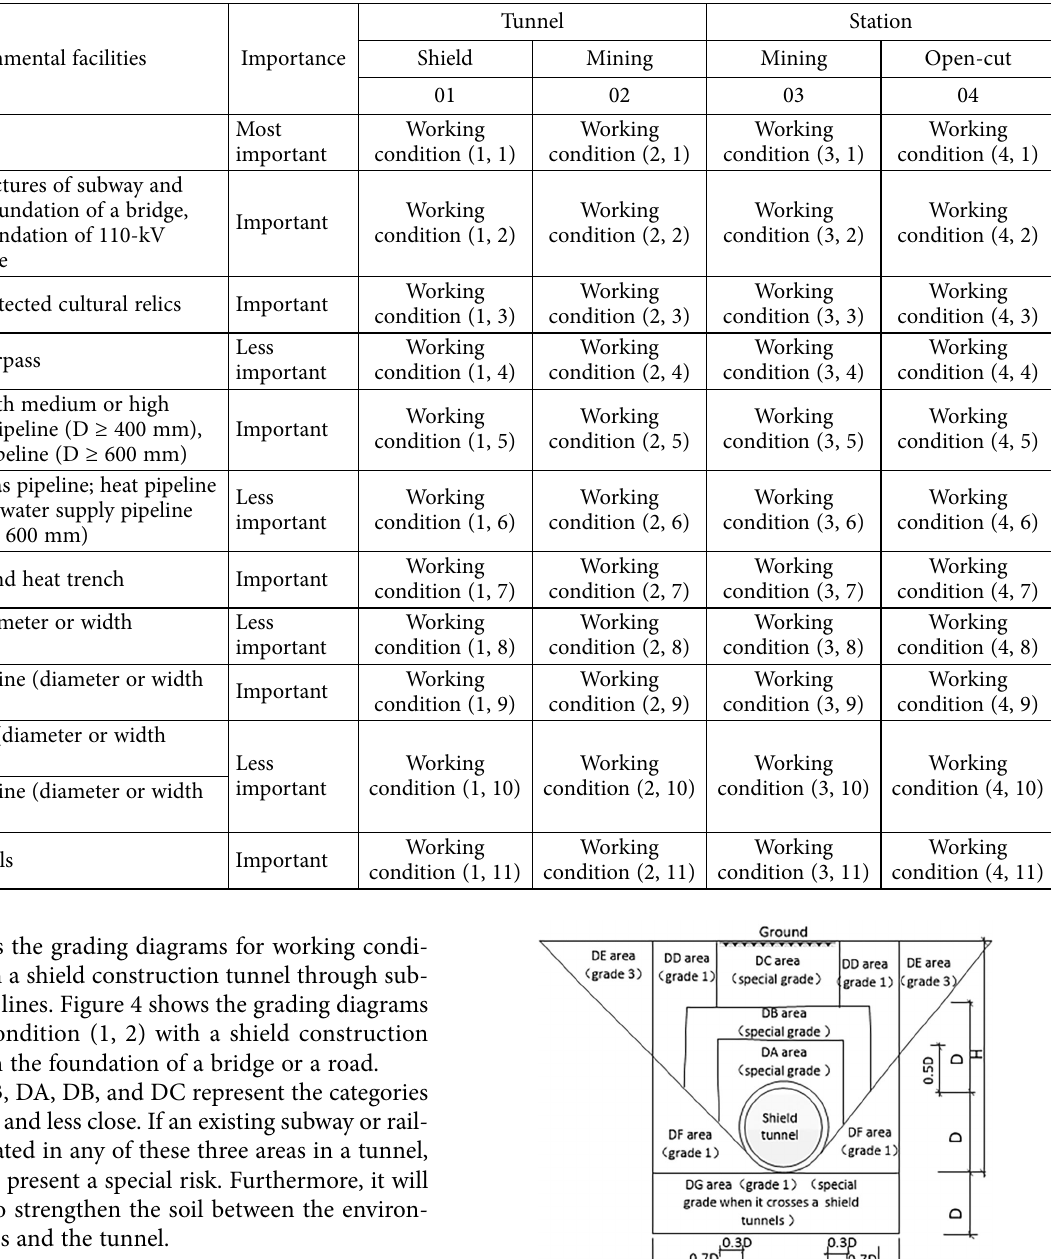
Table 3. Environmental risk conditions caused by subway construction